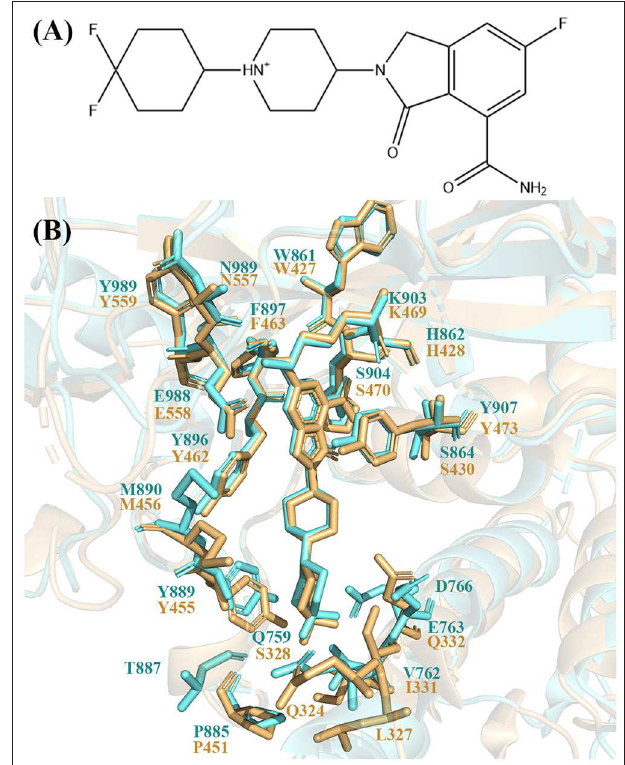
FIGURE 1 | (A) 2D skeleton structure of the compound NMS-P118. The plus sign indicates the positive charge on the N atom in the 1,4-dimethylpiperidin-1-ium group. (B) The binding pocket of NMS-P118 in PARP-1 and PARP-2. The PARP-1 is colored with aquamarine and PARP-2 is colored with light